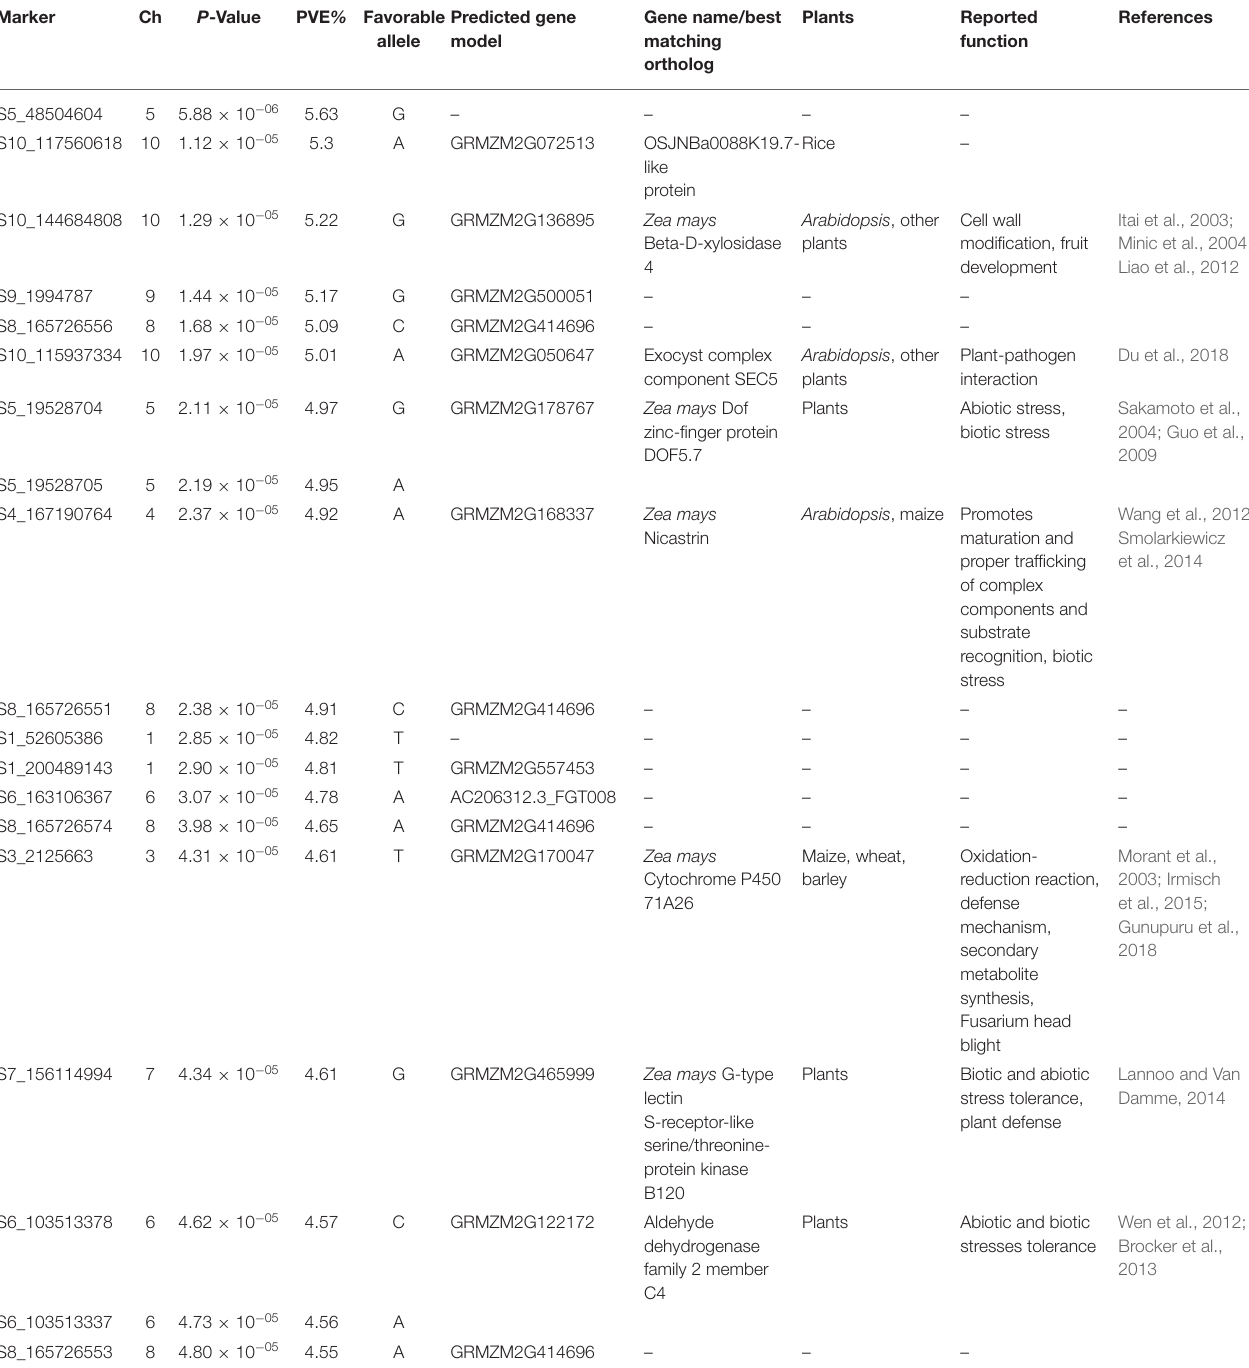
TABLE 2 | Significantly associated single-nucleotide polymorphisms (SNPs) along with the predicted gene model and their function detected by genome-wide association studies in CIMMYT association mapping panel for charcoal rot resistance. Marker Ch P